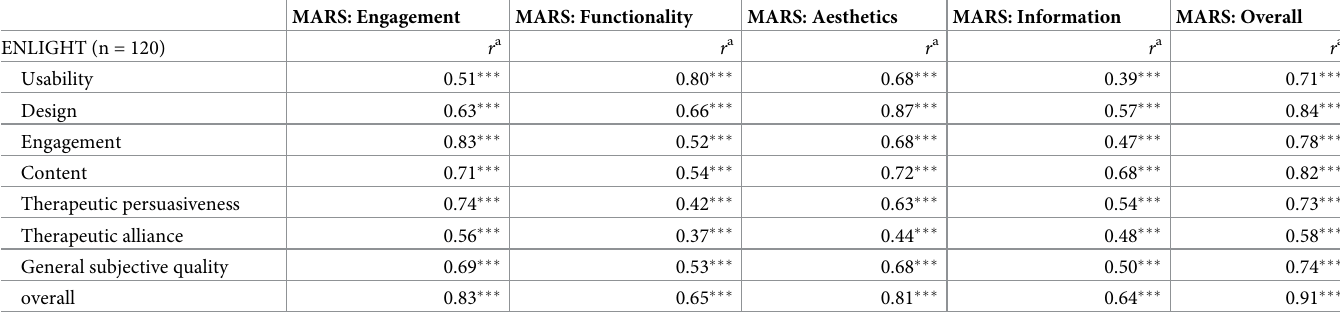
Table 2. Correlations between the MARS and ENLIGHT using a subsample of apps. MARS: Engagement MARS: Functionality MARS: Aesthetics MARS: